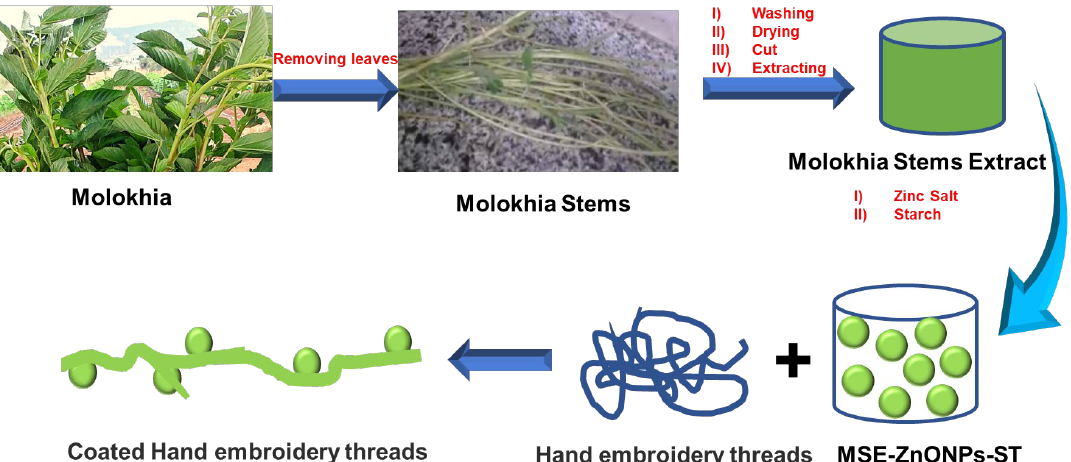
Figure 1. Schematic diagram representing the synthesis of MSE-ZnONPs and a green approach for the coating of hand embroidery threads.